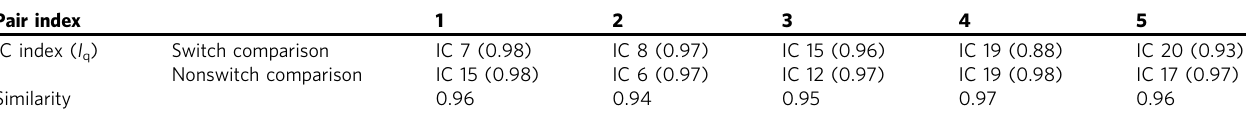
Table 2 Independent component (IC) stability and IC pair similarity in the gate closing